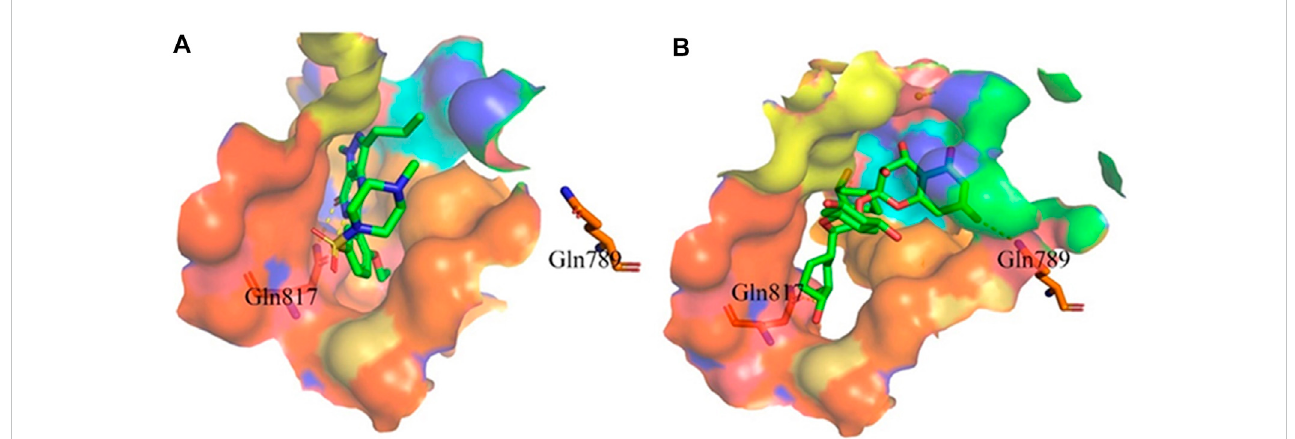
FIGURE 6 BindingmodebetweeninhibitorandPDE5A. (A) Bindingmodebetweensildena fi landPDE5A. (B) BindingmodebetweenproanthocyanidinsandPDE5A. Compounds are shown as a stick model with carbon atoms colored green, and PDE5A (PDB: 1TBF) is shown as the surface. Hydrogen bonds are represented by yellow dashed